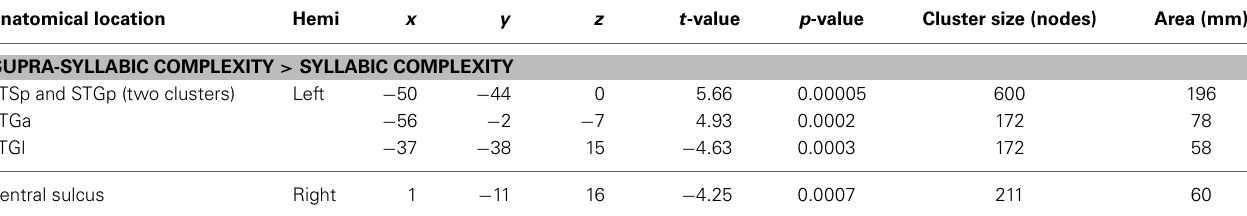
Table 5 | FWE-corrected whole-brain BOLD